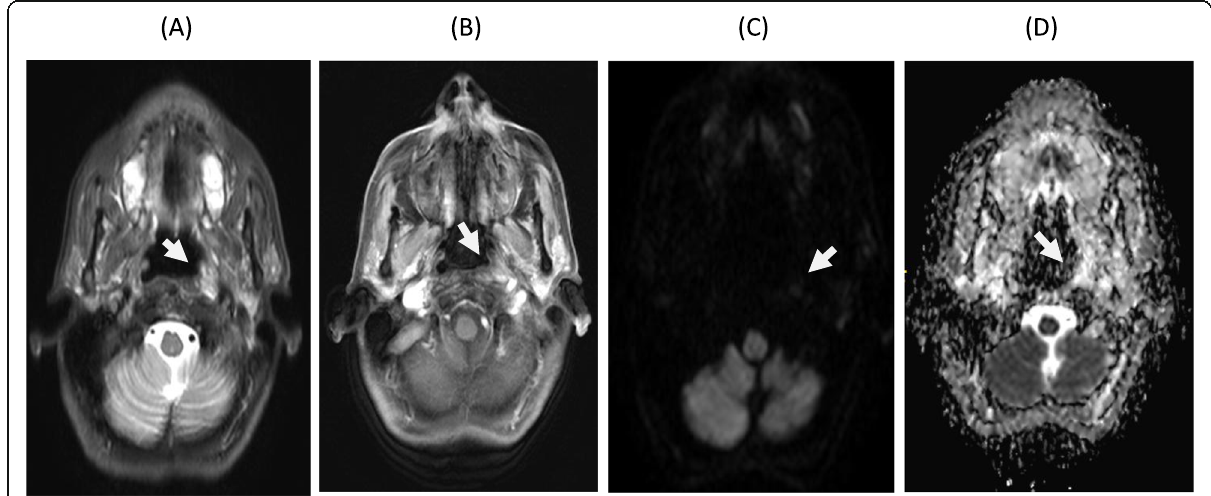
Fig. 5 Pathologically proven recurrent nasopharyngeal carcinoma following radiotherapy. In this case, biopsy and histopathological examination revealed nasopharyngeal carcinoma. However, the lesion was falsely diagnosed by diffusion-weighted imaging (DWI), i.e. wrongly interpreted as “ post-treatment benign changes ” . a Axial T2-weighted image (T2WI) showing a left nasopharyngeal thickening, with high signal intensity. b Axial fat-saturated T1-weighted image (T1WI) post-contrast sequence showing faint, inhomogenous, enhancement of the lesion. c Diffusion-weighted imaging (b1000) revealing the intermediate-to-low signal intensity pattern of the lesion. d Apparent diffusion coefficient (ADC) map revealing the mixed, intermediate-to-high, signal intensity pattern of the lesion, with a mean ADC value of 1.43 × 10 − 3 /mm 2 ; possibility of post-treatment benign changes, rather than tumour recurrence, was